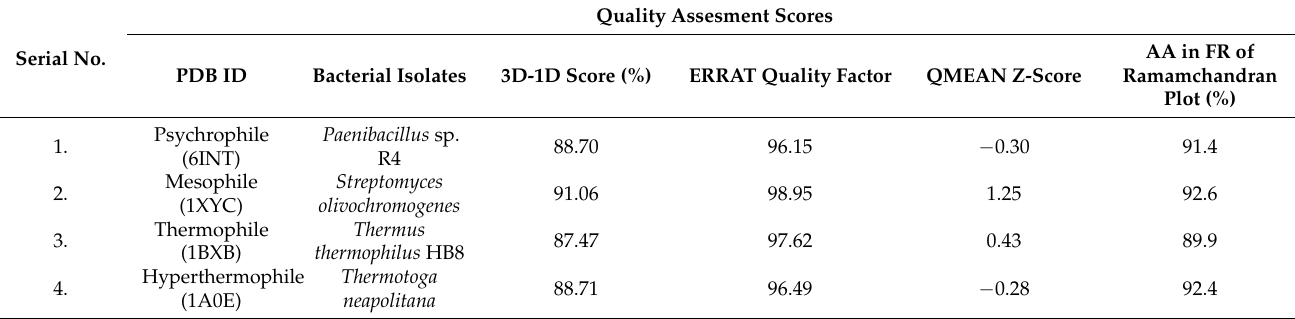
Table 2. Comparative assessment of structural quality of four chosen bacterial xylose isomerase (XI) enzymes from a psychrophile, mesophile, thermophile, and hyperthermophile. Quality Assesment